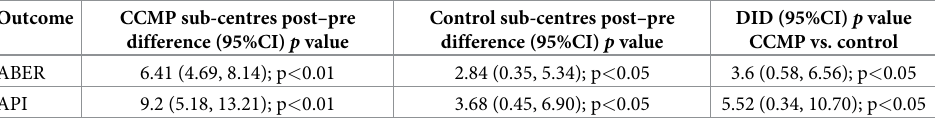
Table 4. Post − pre differences between CCMP intervention and control sub-centres for ABER and API.